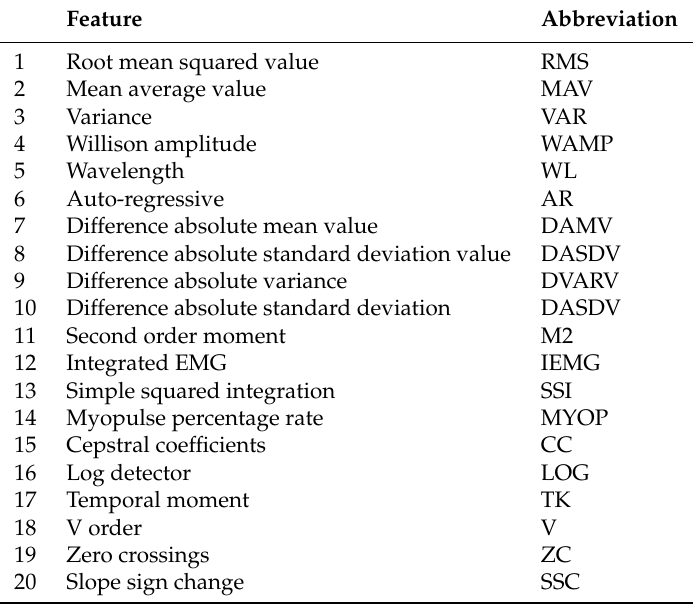
Time-domain and frequency-domain features used in sEMG data processing and classification